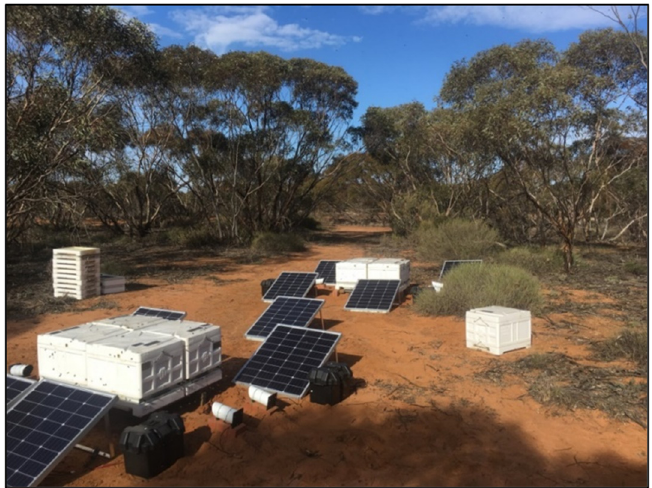
Figure 1. Image of honey bee hives with bottom-mounted pollen traps installed and the Eyesonhives cameras set up with solar power supply for the remote recording of the number of bee flights at the hive entrance.